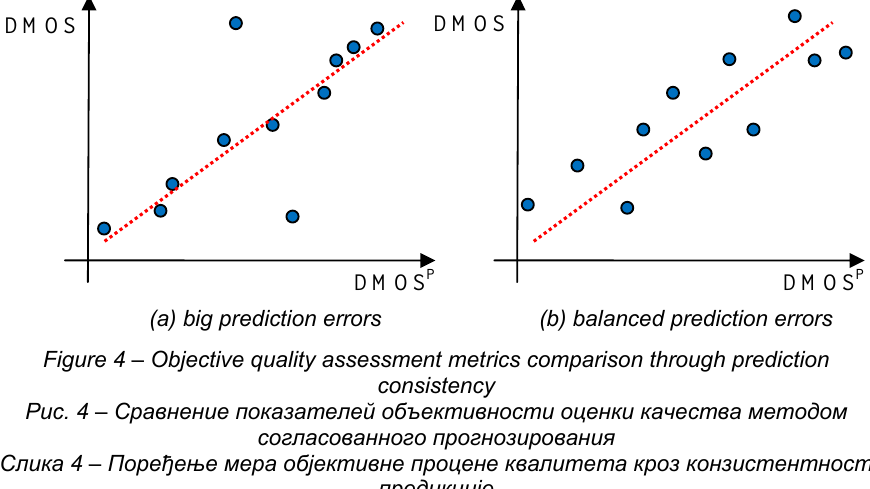
Figure 4 – Objective quality assessment metrics comparison through prediction